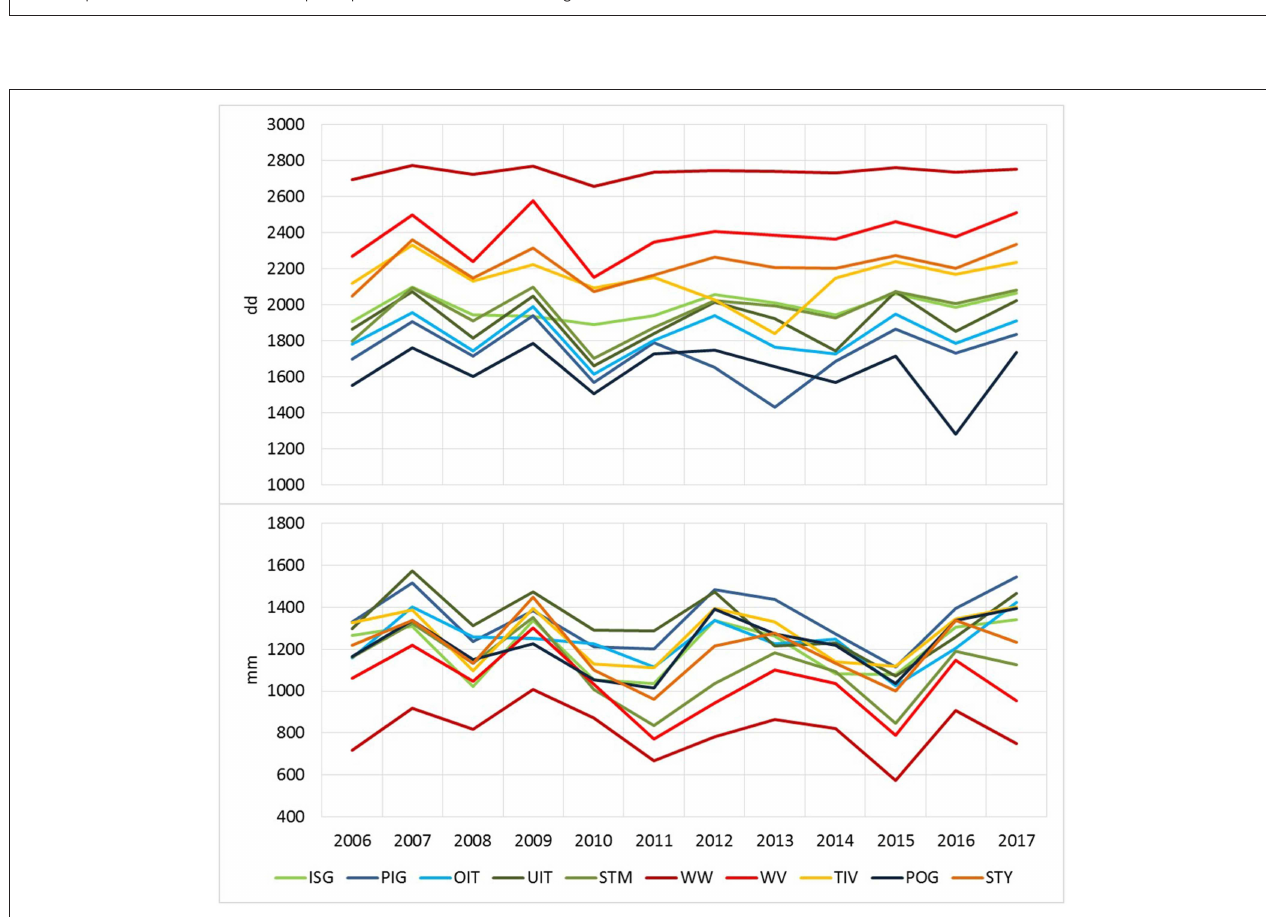
FIGURE 5 | Climatic conditions at ÖBf forest enterprises with regard to effective thermal sums available for I. typographus development (upper graph) and yearly sums of precipitation (lower graph) averaged over forest stands.